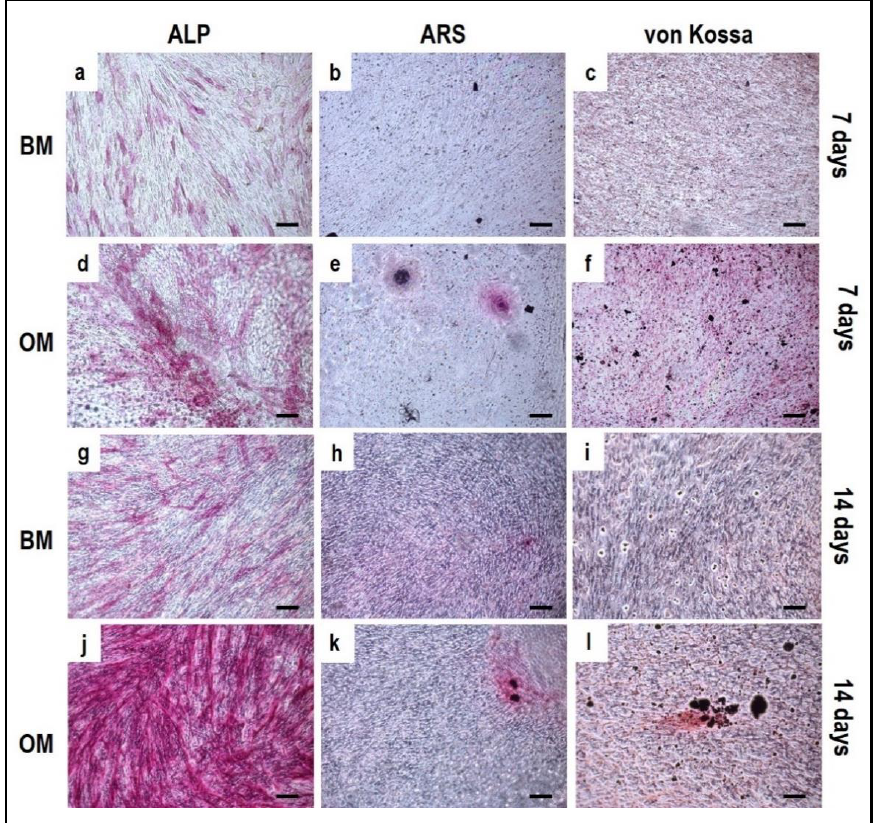
Figure 4. Microphotographs of alkaline phosphatase (ALP) ( a , d , g , j ), Alizarin Red S (ARS) ( b , e , h , k ) and von Kossa ( c , f , i , l ) stainings of OBs derived from the indirect co-culture in basal medium (BM) and osteogenic medium (OM) at 7 and 14 days. ( a – c ): basal medium at 7 days, ( d – f ): osteogenic medium at 7 days, ( g – i ): basal medium at 14 days, ( j – l ): osteogenic medium at 14 days. Scale bar: 100 µm.